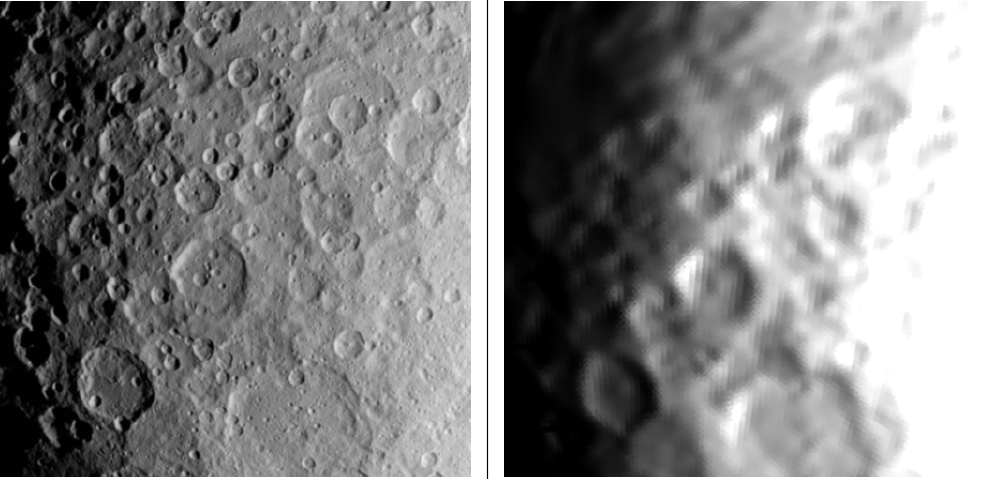
Figure 20. Left: real image as acquired by DAWN Framing Camera FC2. Right: simulated image, 196608-triangle-model of Vesta with 1024 × 1024 px camera resolution. Image ID FC21B0008907- ≈ 24563695343F1B.FIT , χ 2 s